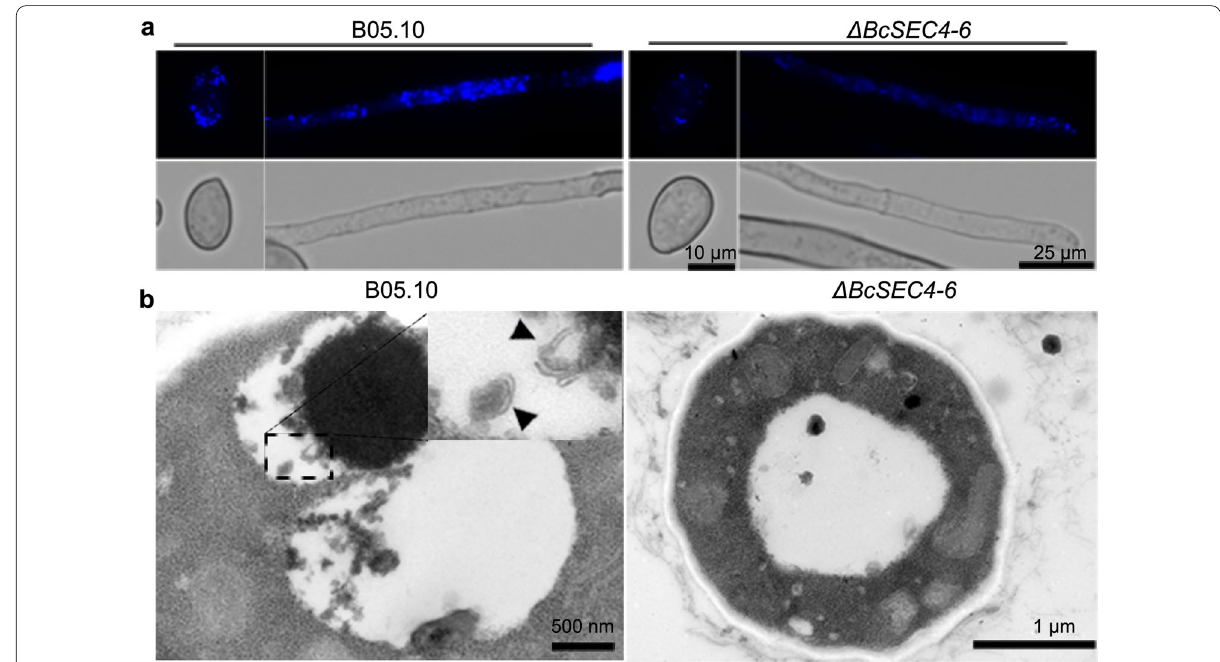
Fig. 7 BcSec4 is involved in autophagy of B. cinerea. a The starved mycelia and conidia stained with MDC and observed under a fluorescence microscope. b Transmission electron microscopy observation of mycelia of B05.10 and the ΔBcSEC4 mutant cultured in nitrogen‑limiting medium (MM‑N) with 2 mM PMSF for 6